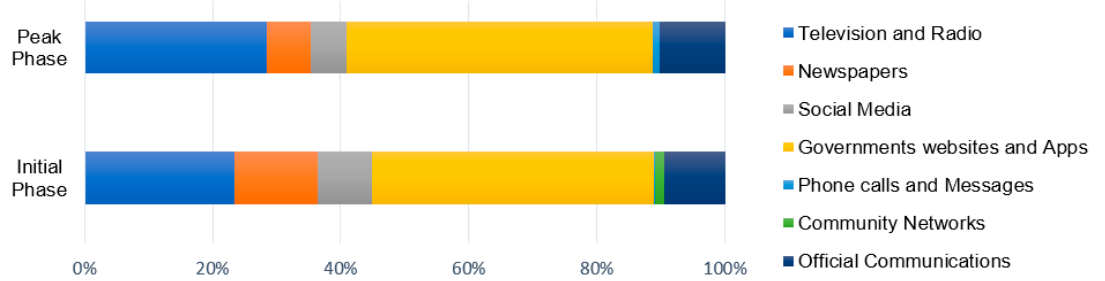
Figure 5. Most reliable source of information identified by the survey respondents for COVID-19.